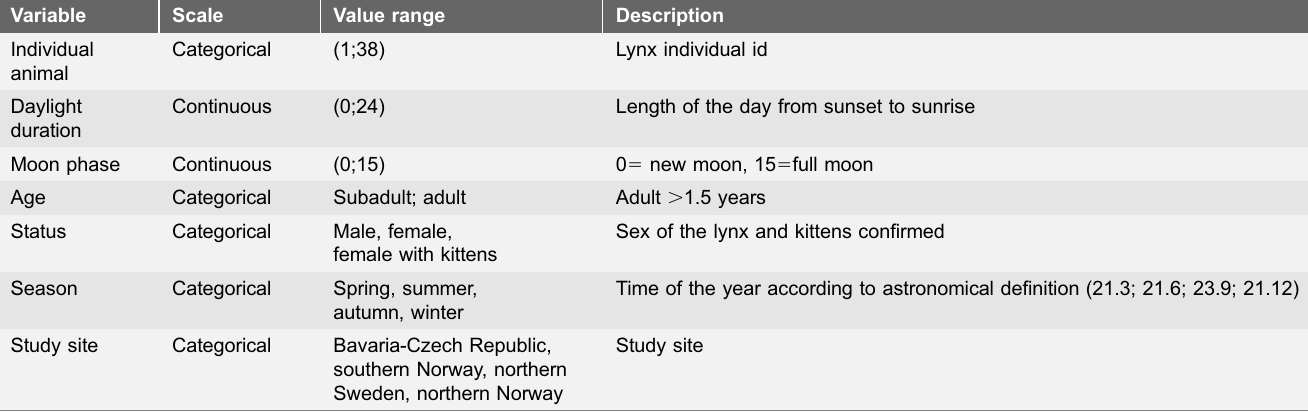
Table 2. Explanatory variables considered in the modelling